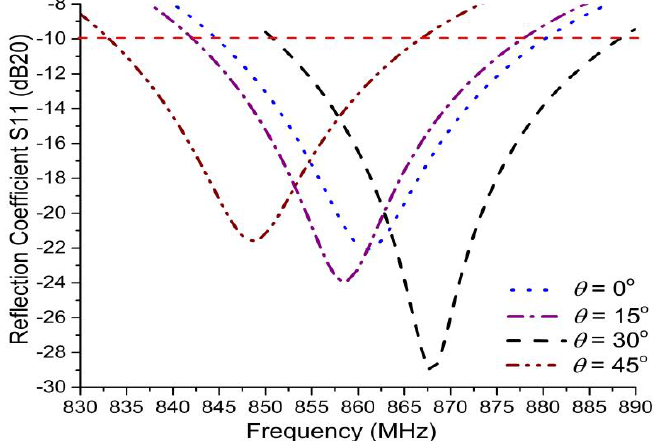
Figure 8. The effect of meandering angle variation on reflection coefficient (S11). With meandering angle variation, the minima of S11 curves fluctuates from −22 to −29 dB, while the tag antenna bandwidth is a little bit reformed (from 33 to 37 MHz). The tag antenna has a minimum reflection coefficient of −29 dB and maximum bandwidth of 37 MHz under −10 dB S11 at θ = 30°.